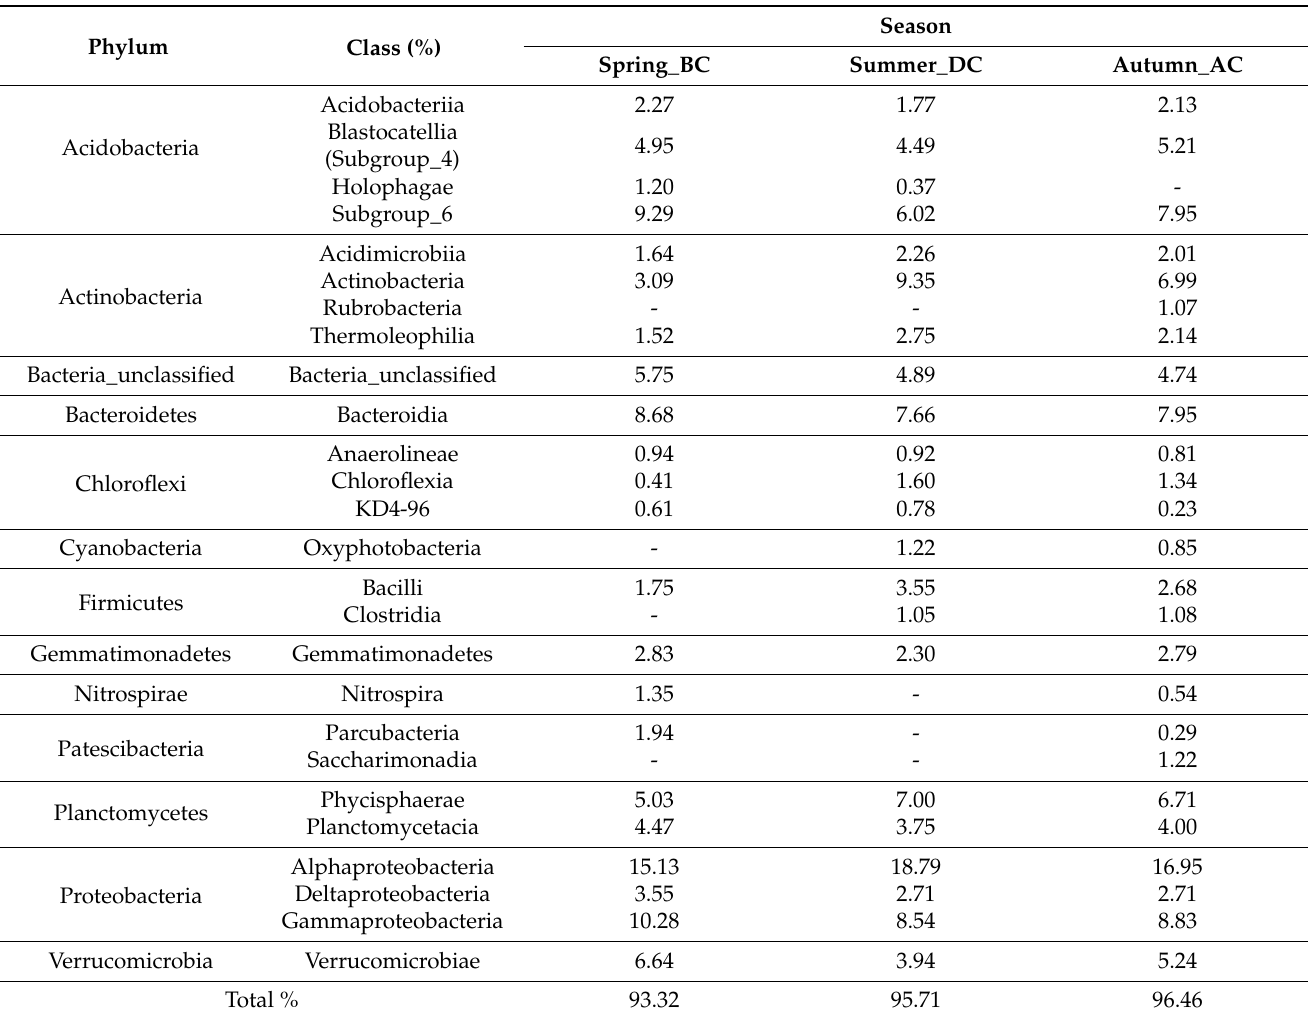
Table 2. Relative abundance (%) of bacterial classes at rate greater than 1% for Spring_ before cultivation (BC), Summer_during cultivation (DC), and Autumn_after cultivation (AC) across all field sites. The dash symbol indicates absence of the class from the respective